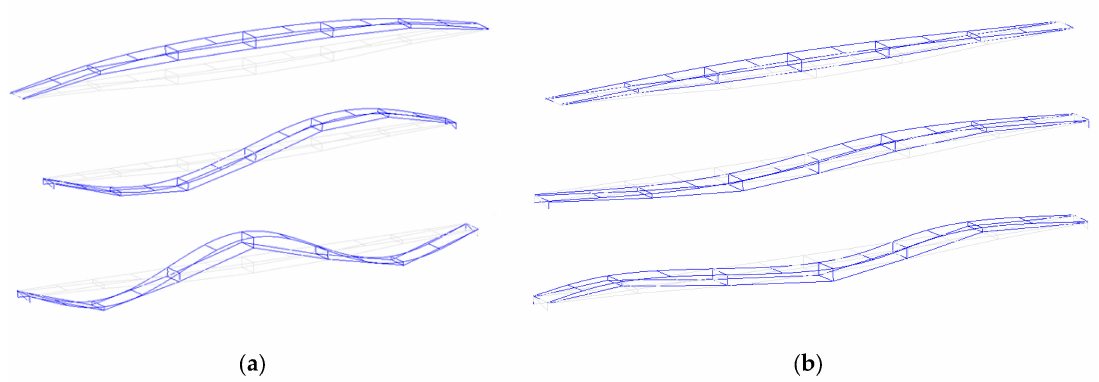
Figure 7. Finite element mode shape diagram. ( a ) Vertical mode, ( b ) Transverse